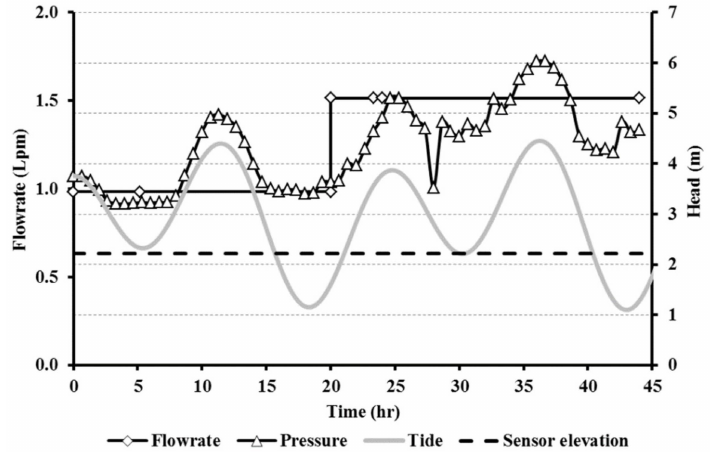
Figure 2. Variation of the flow rate and pressure during tracer injection. The injection occurred until t = 44 h. The average injection concentration between 0.0 h and 33 h was 88 mg / L, after which it was reduced to 0.0 mg /